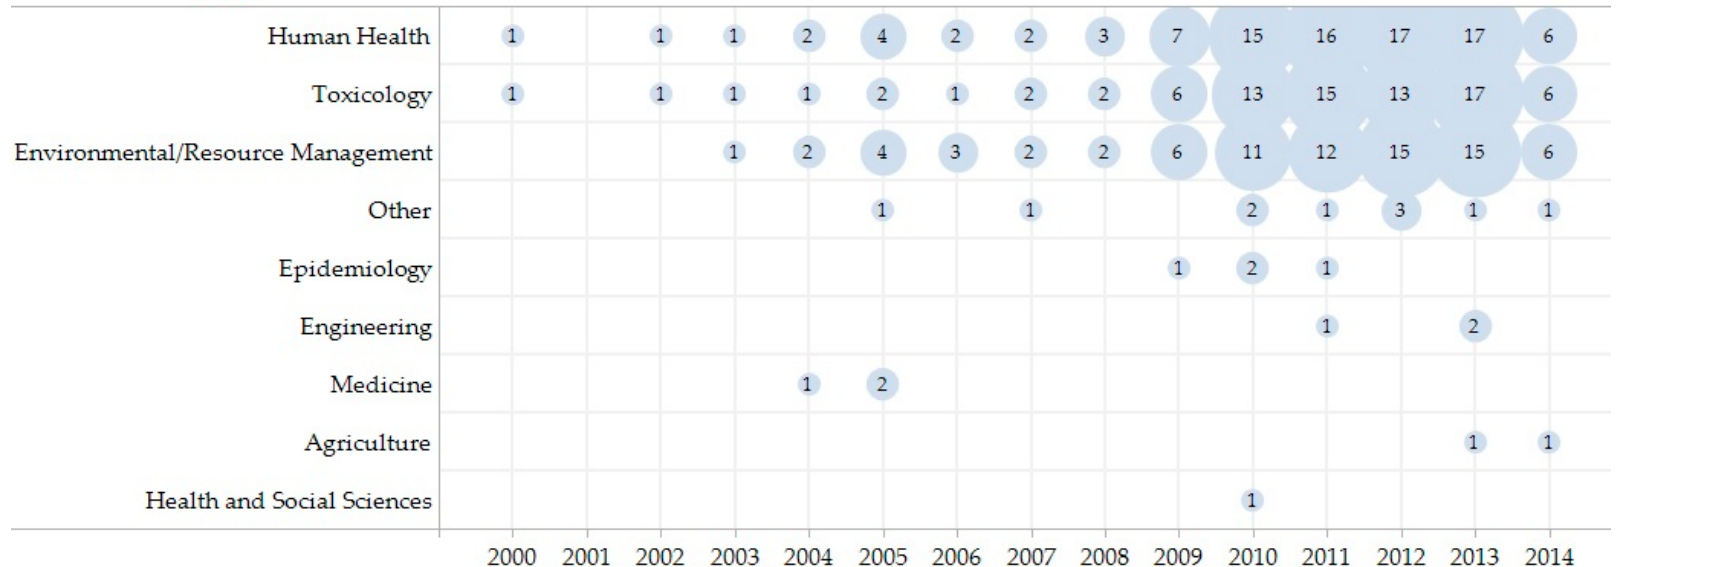
Figure 3. Scopin review studies by sector and year. Sectors are not mutually exclusive.